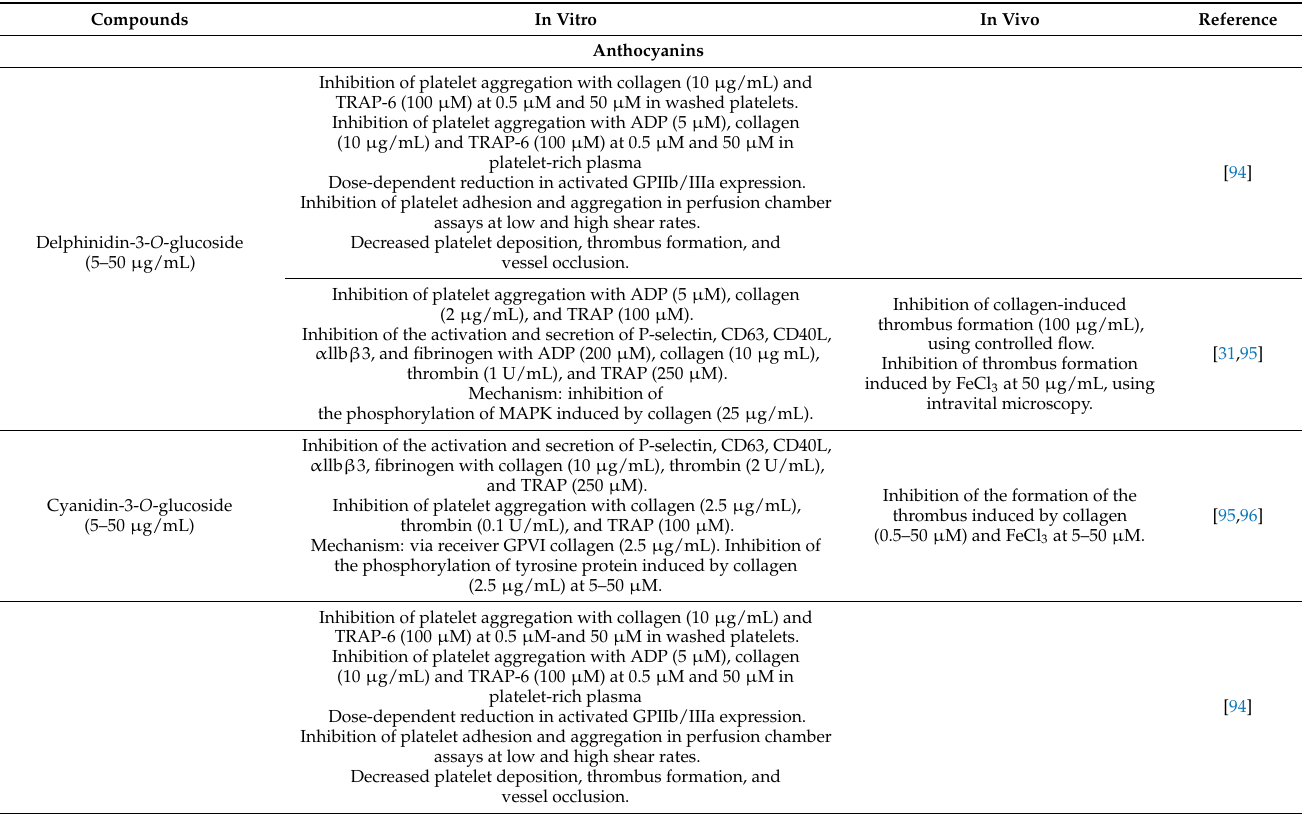
Delphinidin-3- O -glucoside (5–50 µ